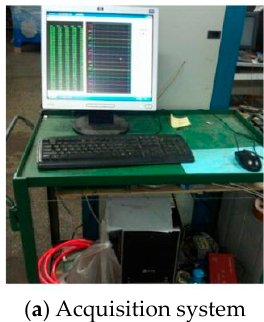
Figure 11. Data acquisition system. Figure 10. Sensors.